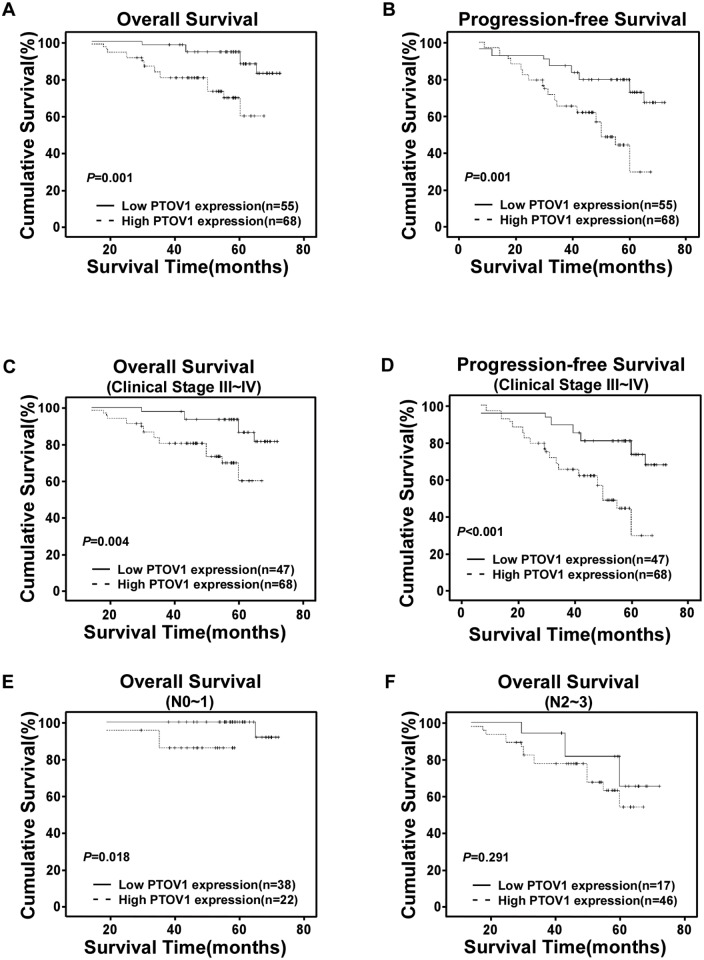
Kaplan-Meier curves with univariate analysis (log-rank).(A and B) OS (A) and PFS (B) rates for cases with high PTOV1 expression versus cases with low PTOV1 expression levels in all patients. (C and D) OS (C) and PFS (D) rates for late clinical stage cases (stage III/IV) with high PTOV1 expression versus cases with low PTOV1 expression levels. (E) OS rate for cases with high PTOV1 expression versus cases with low PTOV1 expression in patients with N0-N1 grade tumors. (F) OS rate for cases with high PTOV1 expression versus cases with low PTOV1 expression in patients with N2-N3 grade tumors.